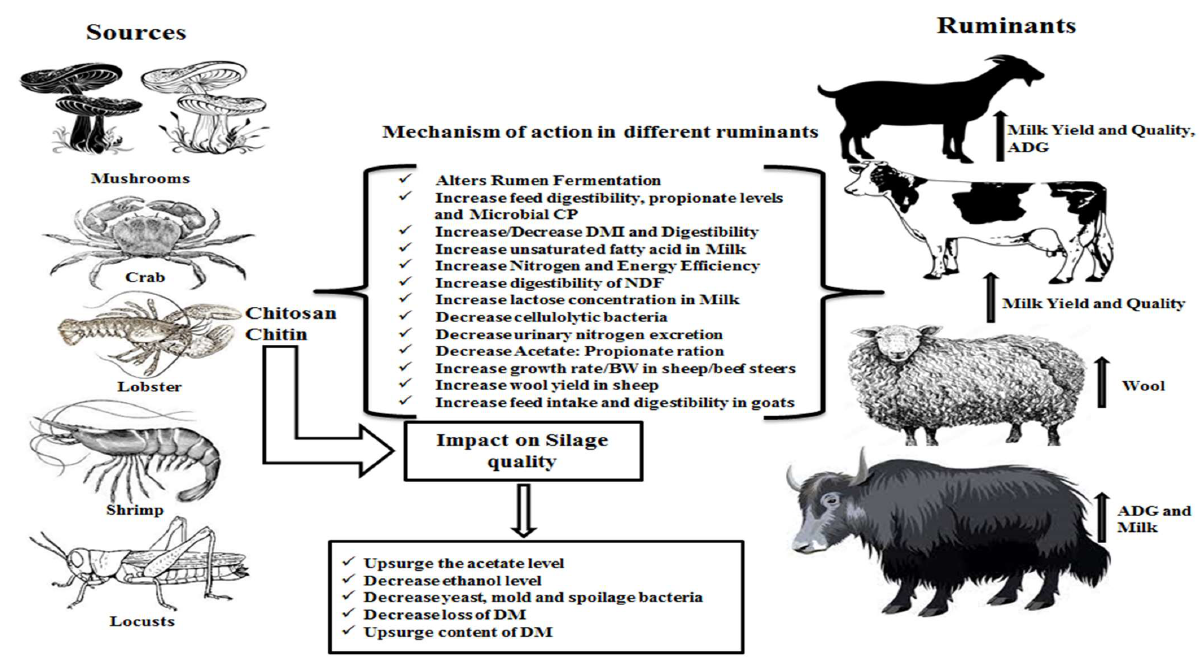
Figure 3. Schematic diagram of chitin and chitosan sources and their mode of action in ruminants and quality of silage.